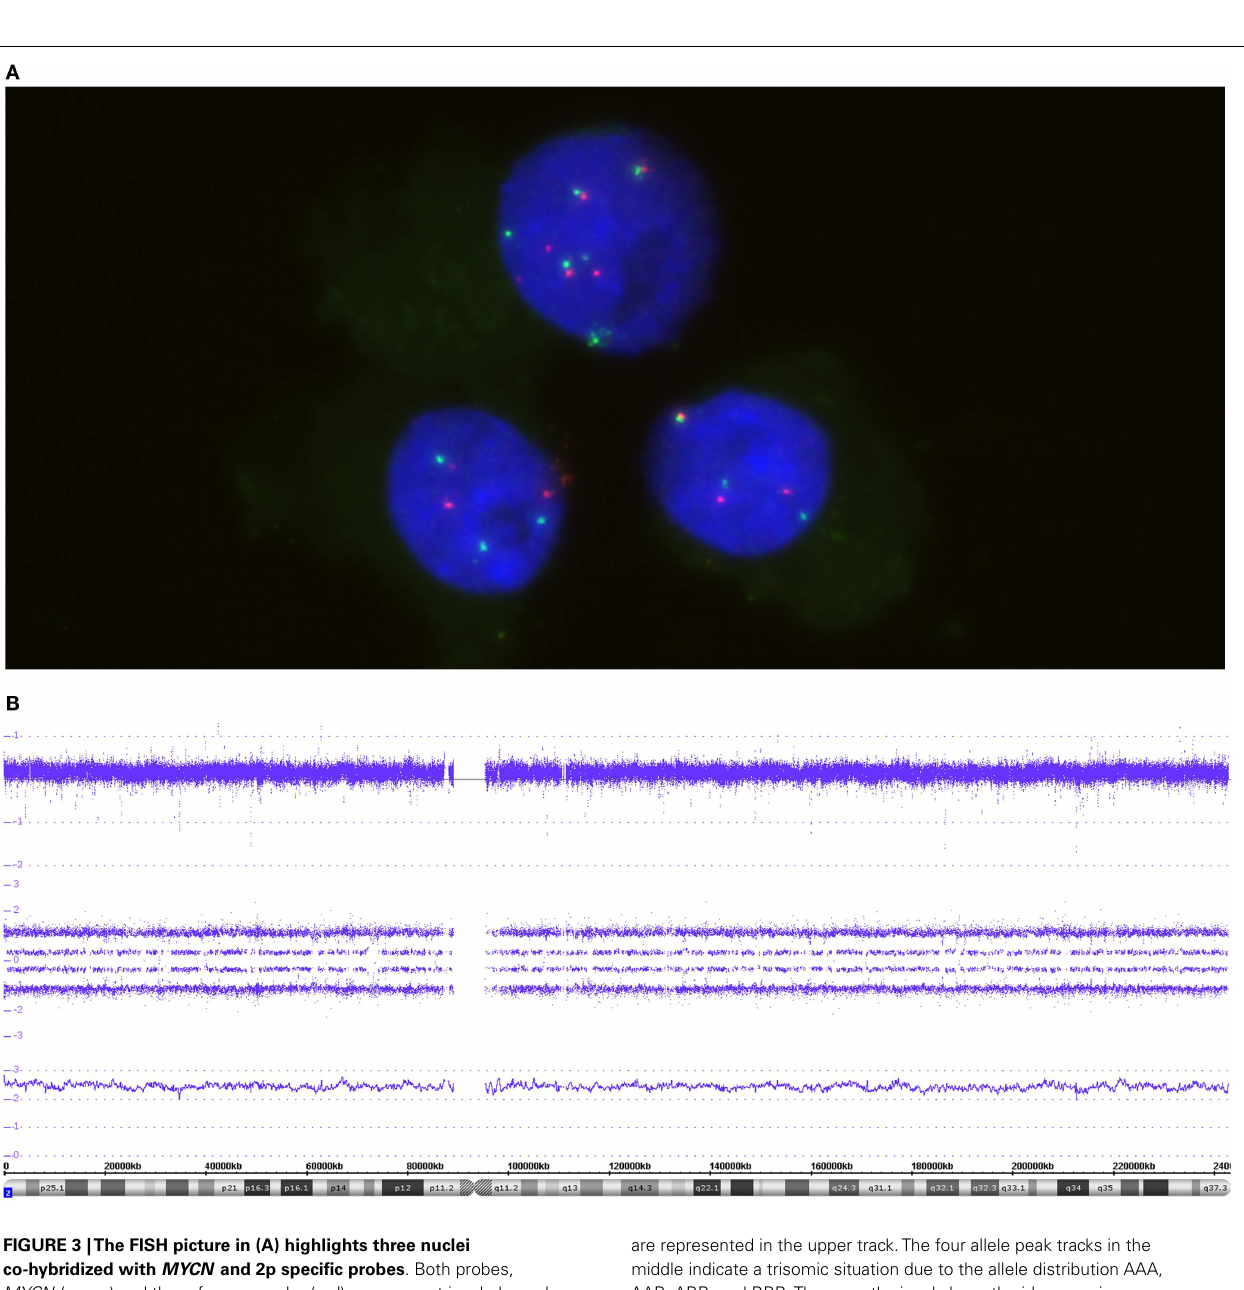
FIGURE 3 |The FISH picture in (A) highlights three nuclei co-hybridized with MYCN and 2p specific probes . Both probes, MYCN (green) and the reference probe (red), are present in a balanced manner – either 3 pairs or 6 pairs in the upper cell. (B) The SNP array profile for chromosome 2. Copy number probe intensities (log 2 ratio)